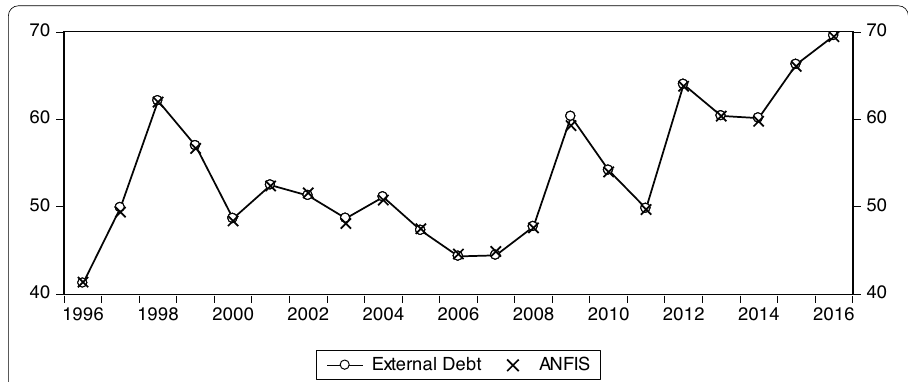
-1.2-0.8-0.40.00.40.8 RMSE=0.359 MAPE= 199619971998199920002001200220032004200520062007200820092010201120122013201420152016 Fig. 4 a Plot of the ANFIS forecasting errors with the original external debt in Malaysia; b scatter plot of the ANFIS forecasting against external debt in